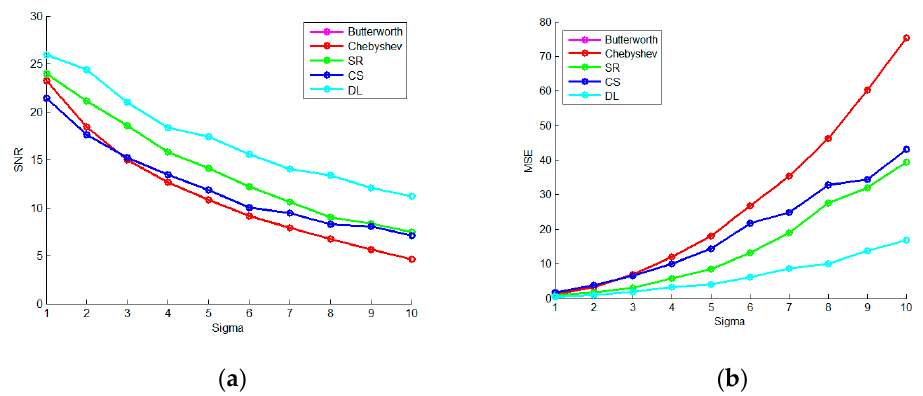
Figure 15. The Experiment on Intensity Change of Noise ( a ) is the SNR curve of the FIR filtering and three spare denoising methods when the sigma changes from 1 to 10, and ( b ) is the MSE curve of the denoising methods when the sigma changes from 1 to 10.